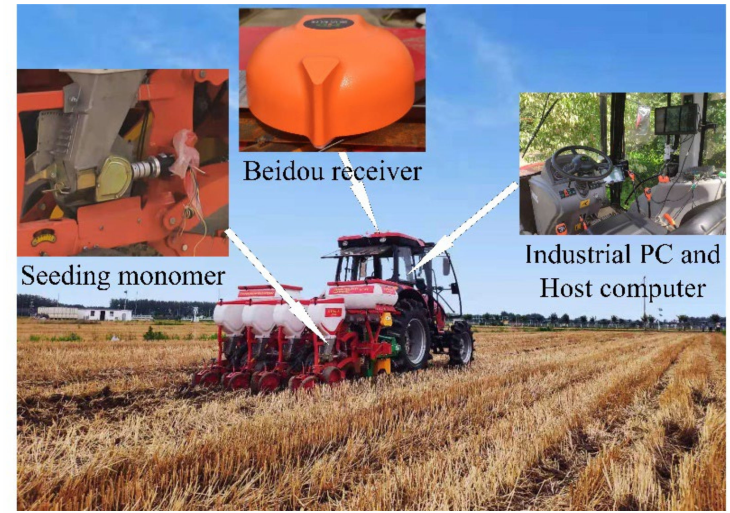
Figure 8. The field